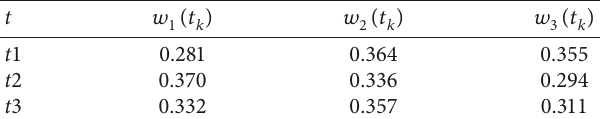
Table 2: Attribute